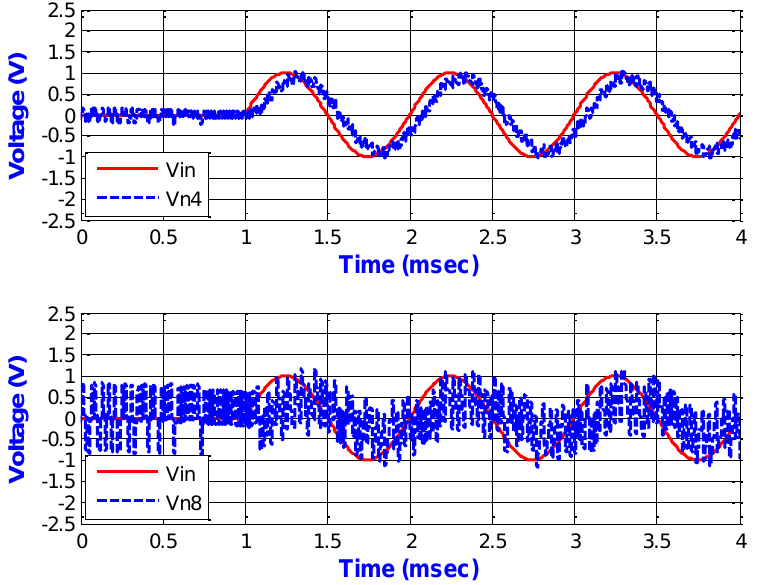
Figure 17. The simulation results of the SDM circuit from nodes n4 and n8 in Figure